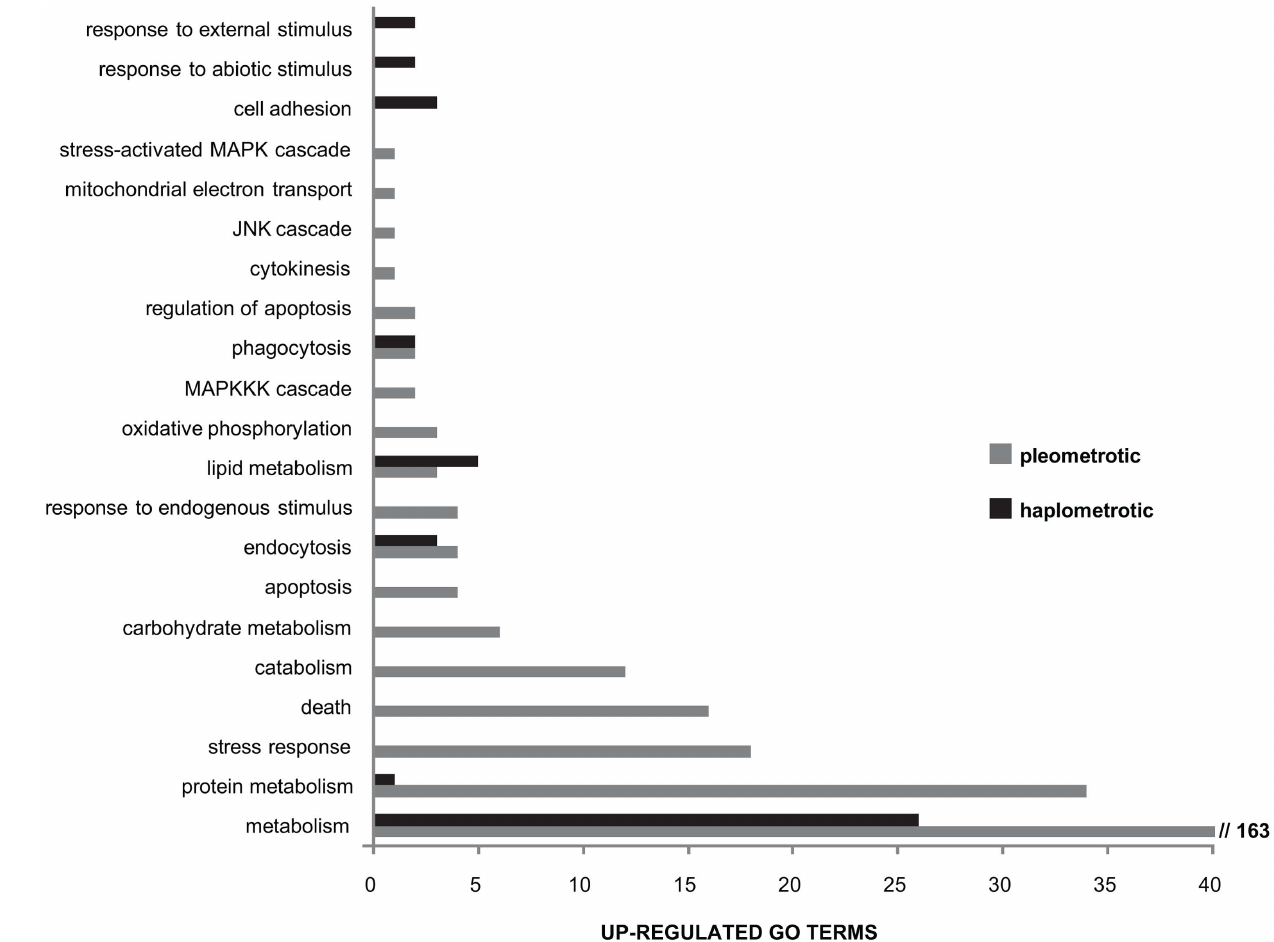
Figure 4. Directional expression of immune-associated GO terms. Overview of larger functional categories encompassing the immune- associated GO terms that were overrepresented among genes upregulated in haplometrotic (grey bars) and pleometrotic (black bars) queens. This result was obtained by overlapping the list of immune system gene classes available in the cateGOrizer with the two lists of significantly enriched GO terms in experiment 1 (Functional Annotation Chart, P , 0.05), i.e. cluster 1 for transcripts upregulated in haplometrotic queens and cluster 2 for transcripts upregulated in pleometrotic queens (see Tables S8 and S9, respectively).